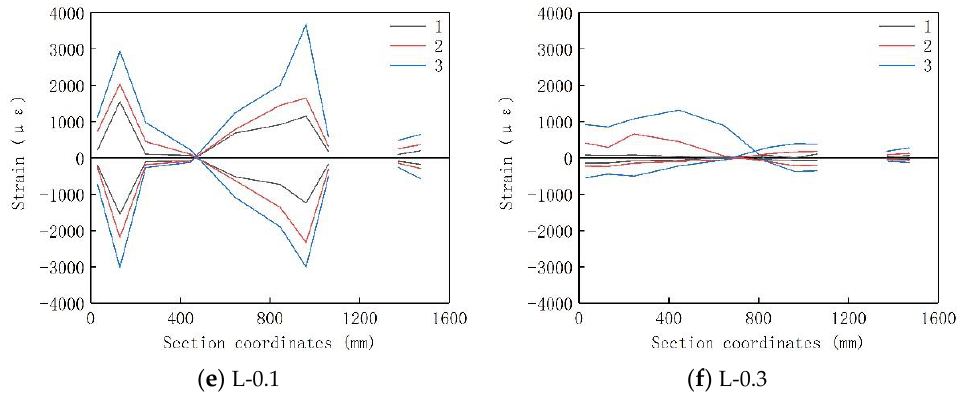
Figure 15. Strain of section.